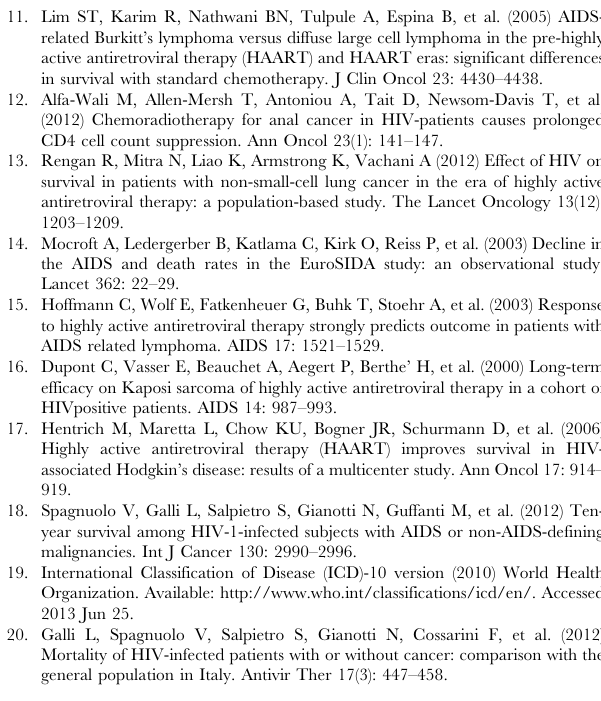
Table S1 The five-year relative survival (age and gender-standardized) in the Italian general population for the cancers diagnosed between 2000 and 2004, and the 5-years relative survival in the Master cohort for the cancers diagnosed in the period